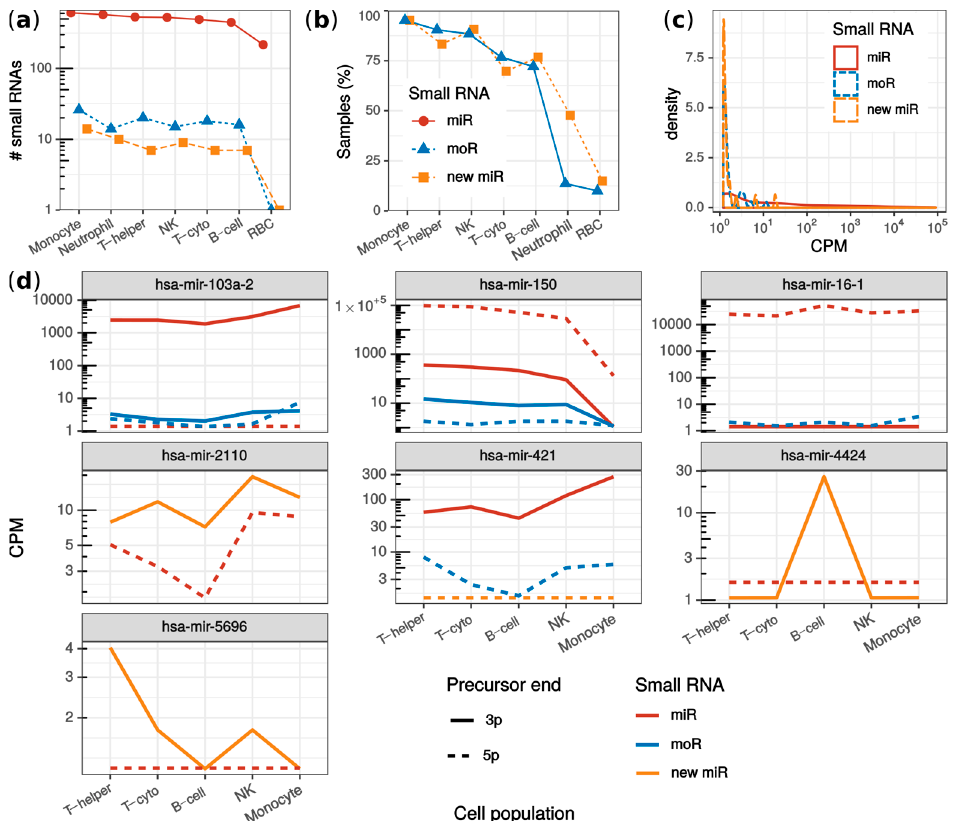
Figure 4. Analysis of monocytes, neutrophils, red blood cells, B-cells, helper T-cells, cytotoxic T-cells and natural killers from the JUZ dataset. ( a ) fraction of samples per cell population in which new miRNAs and moRNAs were detected; ( b ) number of sRNAs detected in each cell population grouping by miRNAs (red), new miRNAs (yellow) and moRNAs (blue); ( c ) sRNA expression (in counts per millions; CPM) distribution comparing known miRNAs (red solid line), new moRNAs (dashed yellow line) and moRNAs (blue dotted line); ( d ) moRNAs and new miRNAs with significantly varied expression among blood cell populations. Median normalized expression (CPM) is reported for moRNAs (blue lines) as well as for the other sRNAs expressed by the parent precursor transcript: miRNAs (red lines) and new complementary miRNAs (yellow lines), from either the 3 ′ (solid lines) and the 5 ′ (dotted lines) precursor ends. T-helper: helper T-cells; T-cyto: cytotoxic T-cells; NK: natural killers; RBC: red blood cells; CPM: counts per million mapped reads.